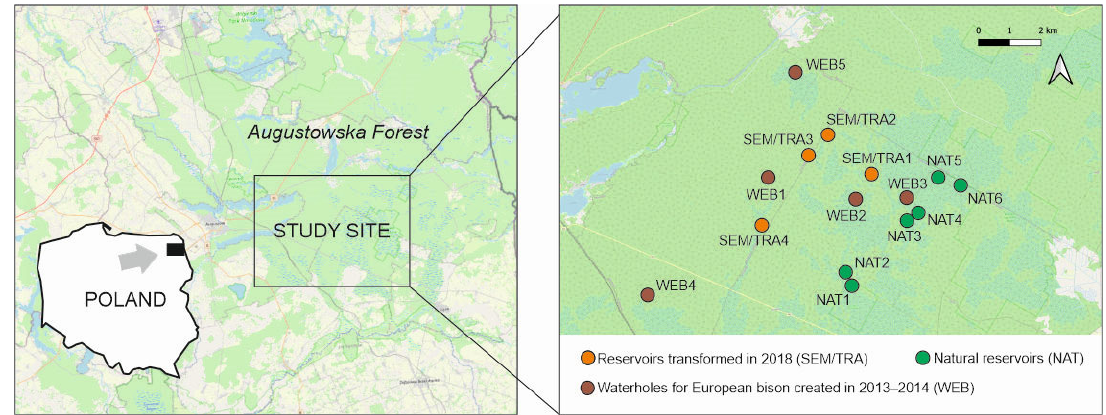
Figure 1. Location of reservoirs studied within the study site.